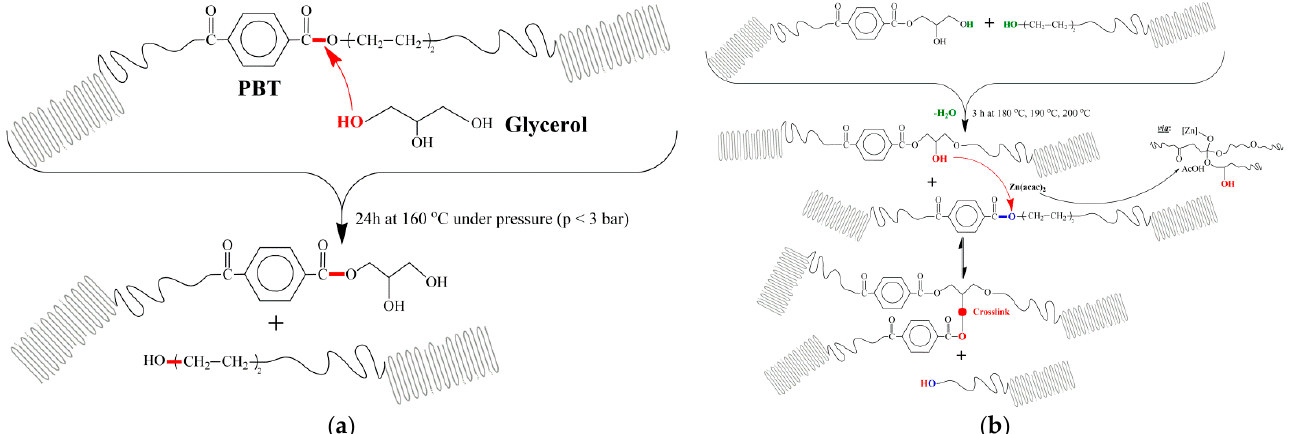
Figure 1. ( a ) Alcoholysis reactions of PBT in the presence of glycerol, ( b ) transesterification reactions of PBT with glycerol in the presence of Zn(acac) 2 during the solid state polymerization step of the process.